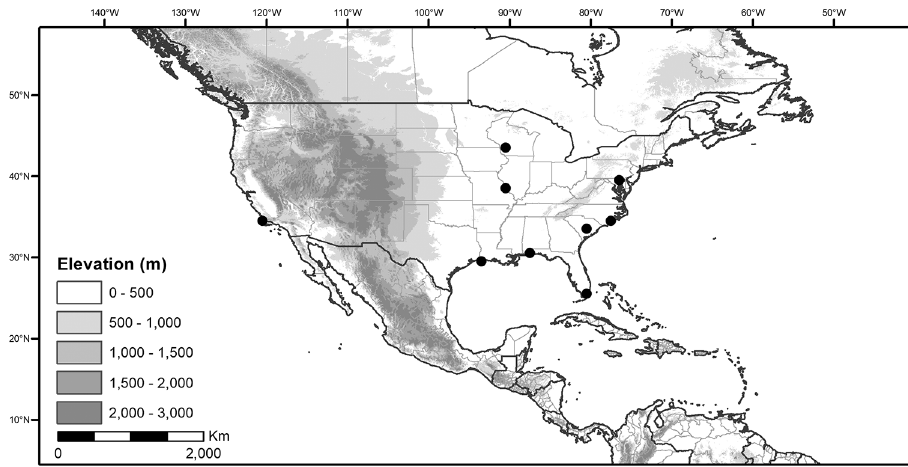
Figure 8. Distribution of Solanum chenopodioides